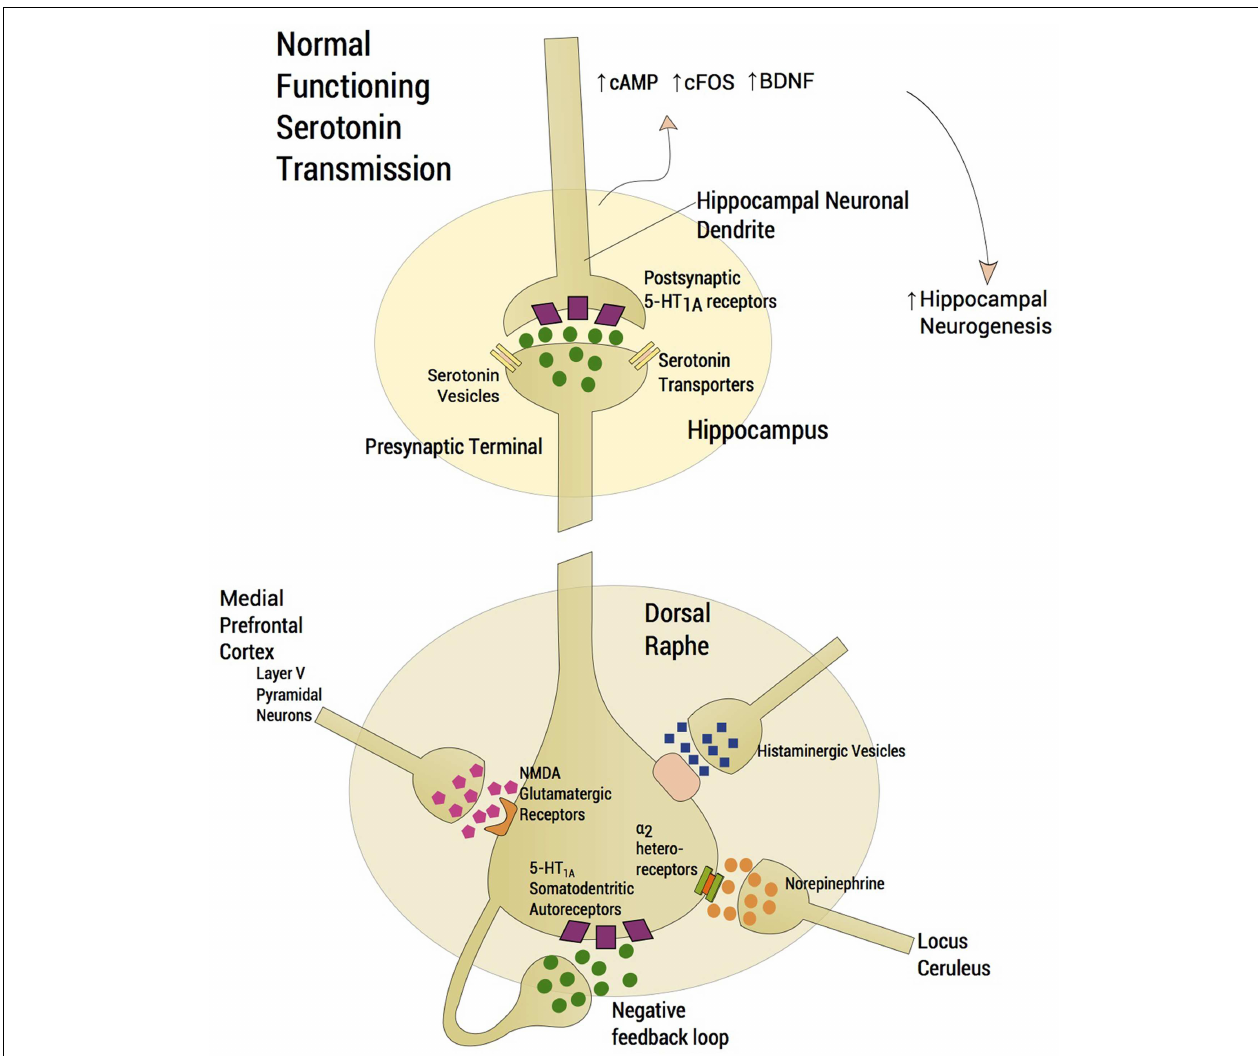
neurons in the dorsal raphe. Increasing norepinephrine neurotransmission from locus ceruleus firing through α 2 -heteroreceptors produces inhibition of dorsal raphe serotonin neuron firing. Histamine exerts an inhibitory effect on serotonin neuronal firing through histamine H 1 receptors. Serotonin neurotransmission enhances neuroplastic effects and intracellular transduction cascades following post-synaptic agonism of 5-HT 1A receptors located in the hippocampus, ultimately resulting in an increase in neurogenesis. Normative neurotransmission at each synaptic junction is represented by the depiction of five “neurotransmitter molecules” located within the synaptic junction and five in the presynapse.